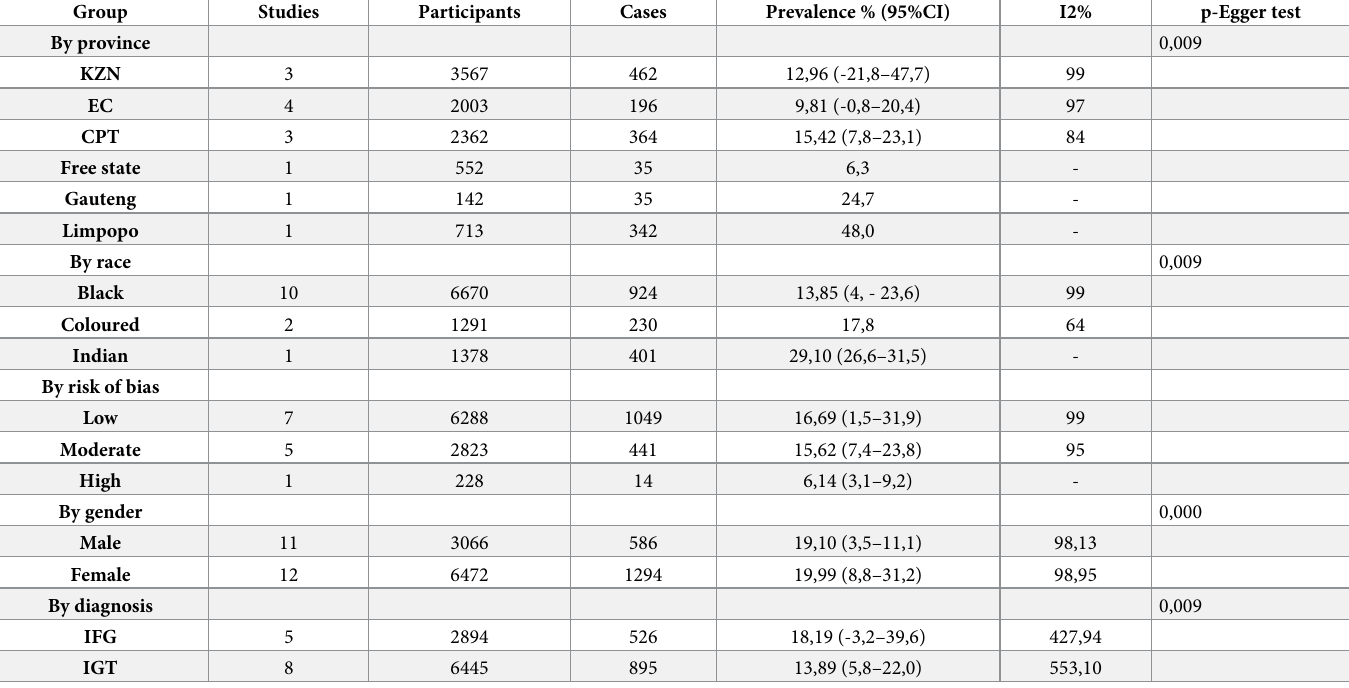
Table 1. Presents the summary of pre-diabetes prevalence in all the considered sub-groups. Except for Limpopo, the more industrialised provinces, such as KwaZulu- Natal (KZN), Gauteng and Cape Town/Western Cape, tend to have a higher pre-diabetes prevalence. The Coloured and Indian populations have the highest prevalence of pre-diabetes. The risk of bias in most studies was low or moderate. The male and female participants have a similar prevalence of pre-diabetes. The IFG detected more pre- diabetic cases than